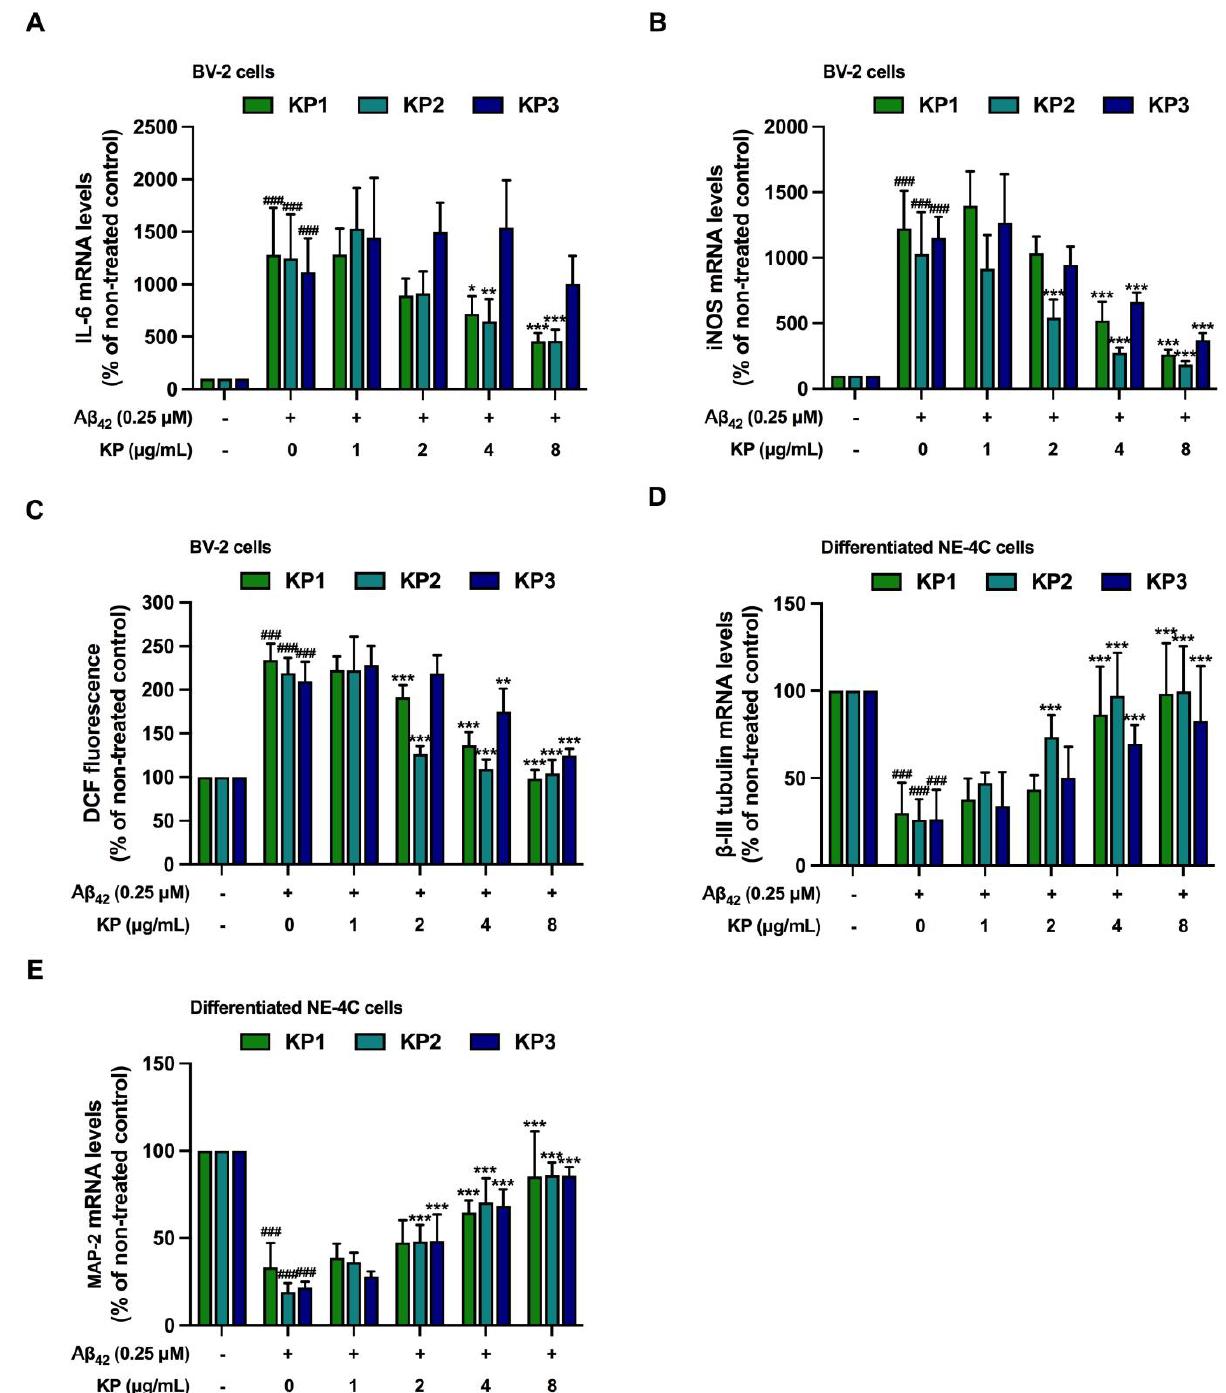
Figure 8. The protective effects of K. parviflora on neurogenesis in the co-culture between differentiated NE-4C and BV-2 cells treated with A β 42 . ( A ) IL-6 mRNA levels of BV-2 cells, ( B ) relative iNOS mRNA levels of BV-2 cells, ( C ) DCF fluorescence of BV-2 cells, ( D ) beta-III tubulin mRNA levels of differentiated NE-4C cells, and ( E ) MAP-2 mRNA levels of differentiated NE-4C cells. The values are mean ± SD of three independent experiments. The ### shows a significantly different between control and cells exposed to Aβ 42 peptides without KP extract at p < 0.001 using one-way ANOVA followed by Tukey’s test. The * shows a significantly different between cells exposed to Aβ 42 peptides without KP extract compared to cells exposed to A β 42 peptides and various concentrations of KP extract (1–8 µ g/mL) using one-way ANOVA followed by Tukey’s test. *, p < 0.05, **, p < 0.01, ***, p <